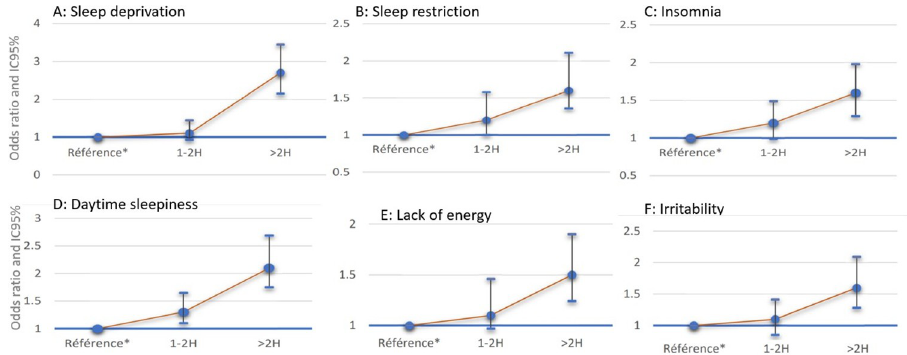
Fig 1. Duration of evening screen time use and